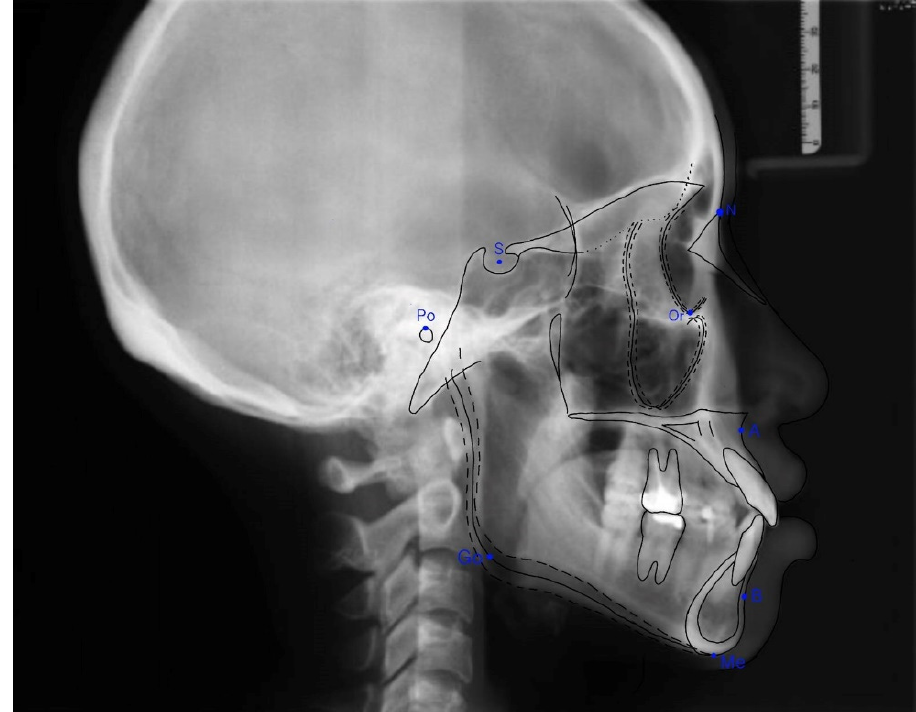
Figure 1. The landmarks used to analyze lateral cephalometric radiographs.